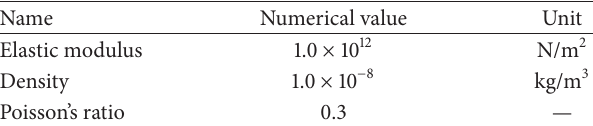
Table 2: Parameters of rigid plate